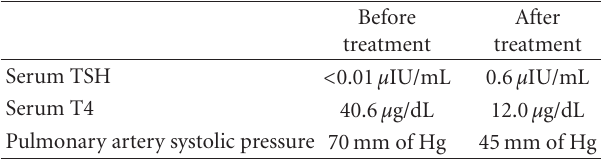
Table 1: Comparison of the patient’s findings before and after treatment with